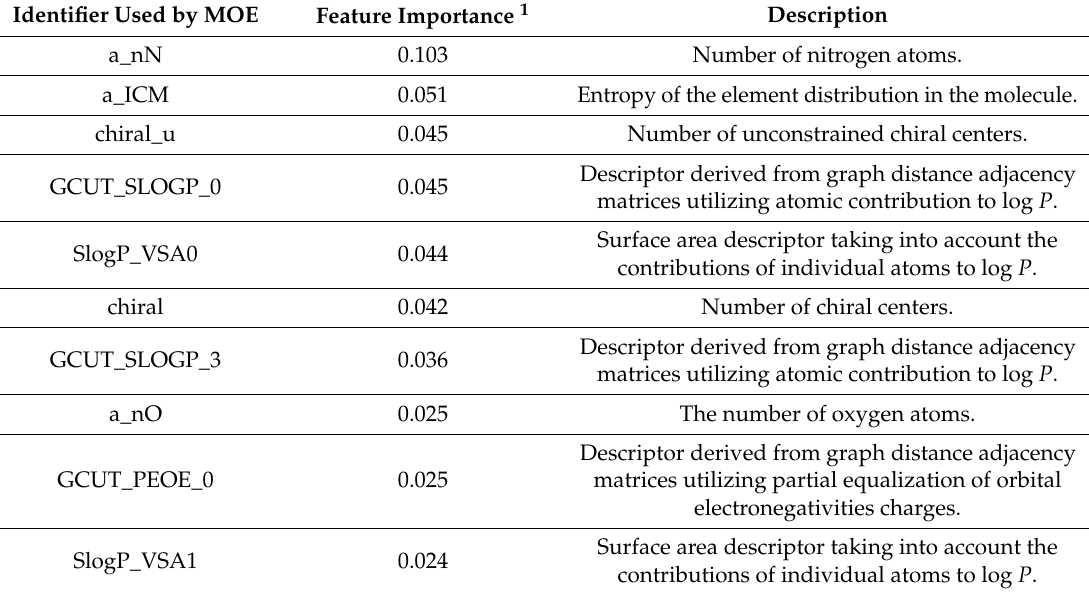
Table 3. Feature importance for the random forest classifier based on MOE two-dimensional